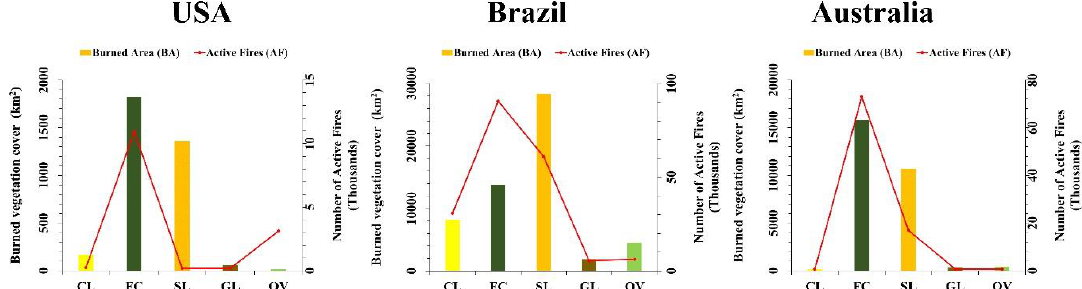
Figure 5. Amount of lost or damaged vegetation cover (km 2 ) and the corresponding number of active fires (AF). CL, FC, GL, OVC and SL denote cultivated land, forest cover, grassland, other vegetation covers and shrubland, respectively.